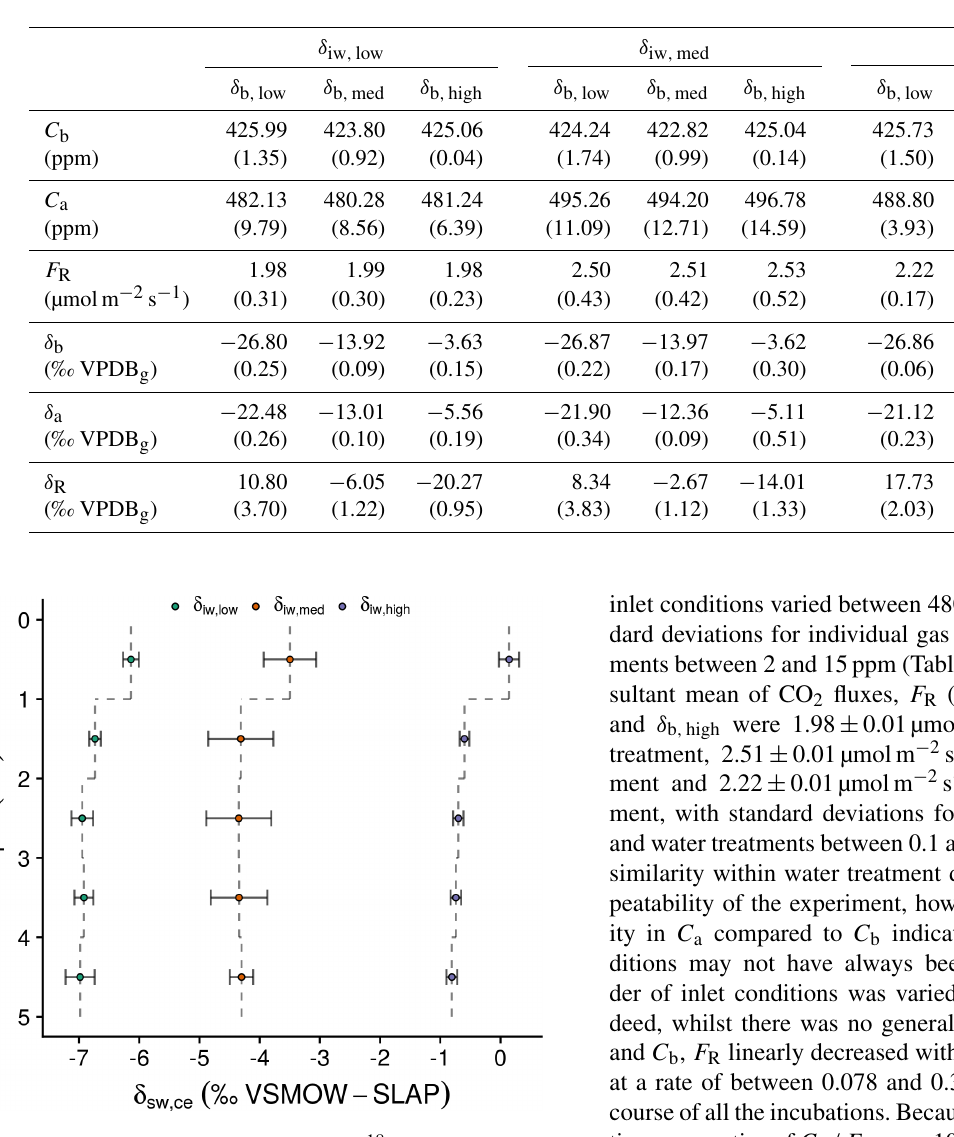
Table 2. Gas exchange data by irrigation water ( δ iw ) treatment at the three different incubation system inlet conditions ( δ b ). Means and standard deviations (in parenthesis) for total CO 2 concentration in the bypass ( C b ) and the chamber ( C a ), the δ 18 O of CO 2 in the bypass ( δ b ) and the chamber ( δ a ), and the net flux of CO 2 ( F R ) and its δ 18 O ( δ R ).